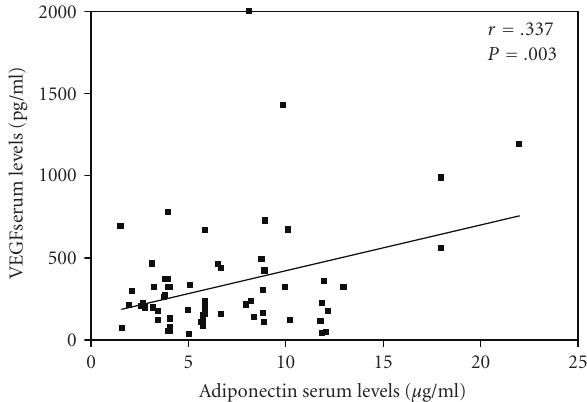
Figure 1: Correlation between serum levels of adiponectin and VEGF. The analysis denotes a significant direct correlation ( r = 0 . 337; P = . 003).